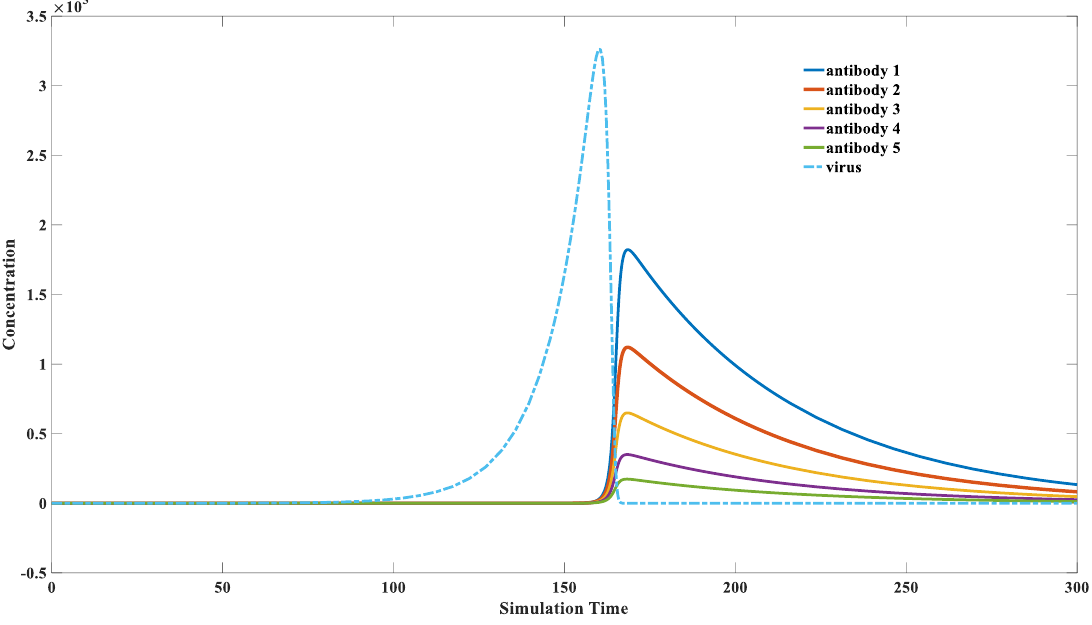
Figure 6. Dynamics of different antibodies with different kinetic attributes. The parameter sets we used are: x (0) = 0, y (0) = 1, z (0) = 1, w = 1, 𝑘 1 = 0.1, 𝑘 2 = 1 × 10 −5 , 𝑘 −2 = 1 × 10 −14 , 𝑘 3 = 1, 𝑘 4 = 2, 𝑘 5 = 0.02, 𝑘 6 = 0.02, for antibody 1; 𝑘 2 = 9 × 10 −6 , 𝑘 −2 = 9 × 10 −15 for antibody 2; 𝑘 2 = 8 × 10 −6 , 𝑘 −2 = 8 × 10 −15 for antibody 3; 𝑘 2 = 7 × 10 −6 , 𝑘 −2 = 7 × 10 −15 for antibody 4; 𝑘 2 = 6 × 10 −6 , 𝑘 −2 = 6 × 10 −15 for